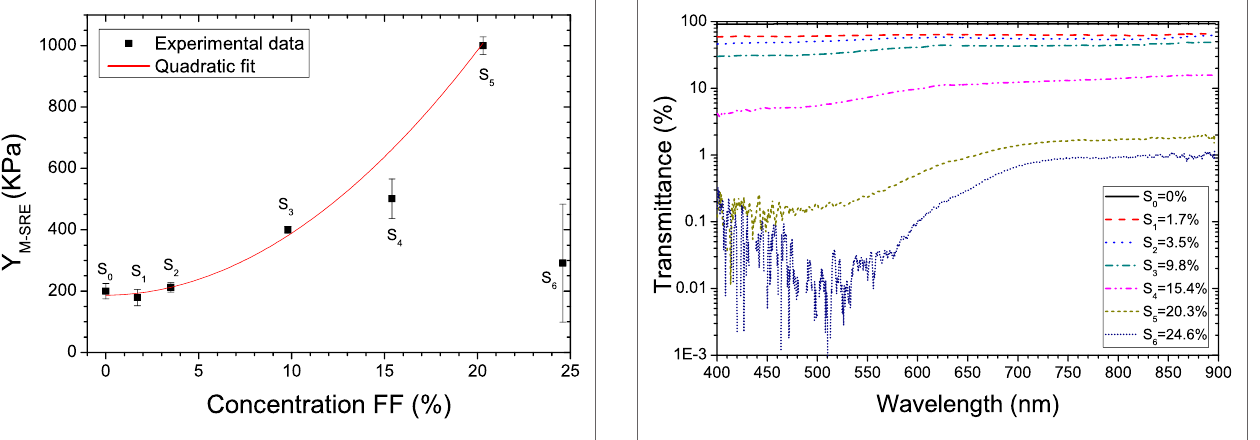
FigUre 5 | Dependence of the Young’s modulus of the M-sre ( Y M-sre ) as a function of the ferrofluid concentration in the PDMs . An increase of Y M-SRE is observed until it reaches the maximum value corresponding to 20.3%, beyond which a drop of Y M-SRE is